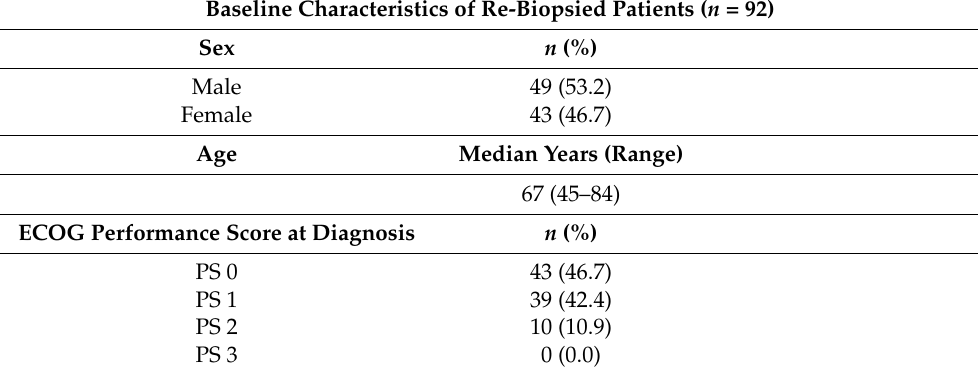
Table 1. Baseline characteristics of re-biopsied